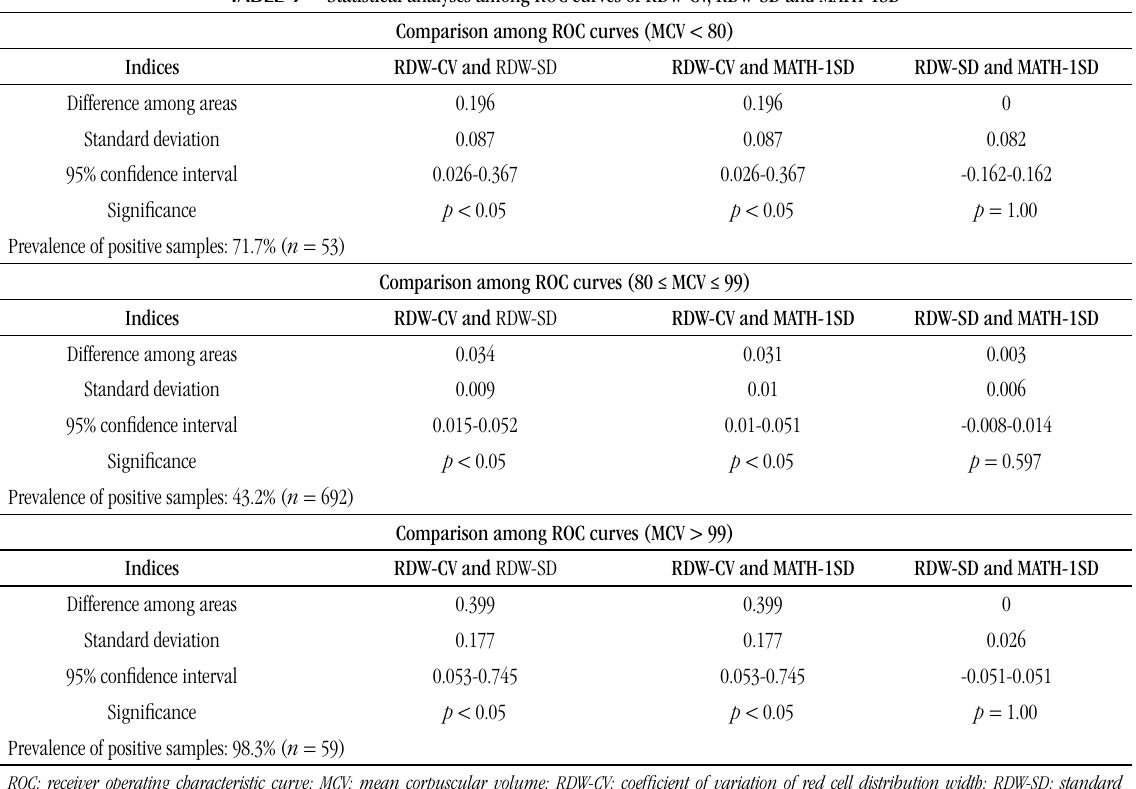
tABLE 3 – Statistical analyses among ROC curves of RDW-CV, RDW-SD and MATH-1SD Comparison among ROC curves (MCV <